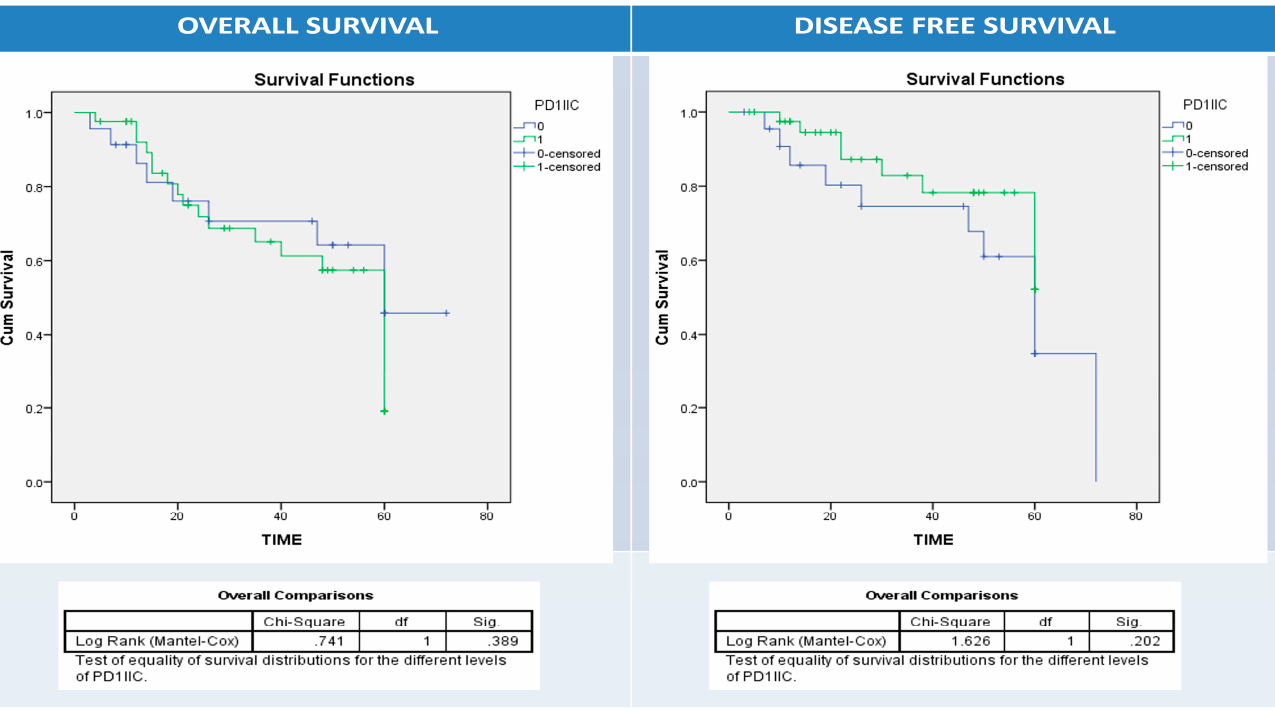
Figure 6. Kaplan–Meier survival curves for overall (right panel) and disease-free survival (left panel) according to IIC PD1 expression (0: blue (-ve PD1 IIC); 1: green (+ve PD1 IIC)). Log Rank test (Mantel–Cox) was used.